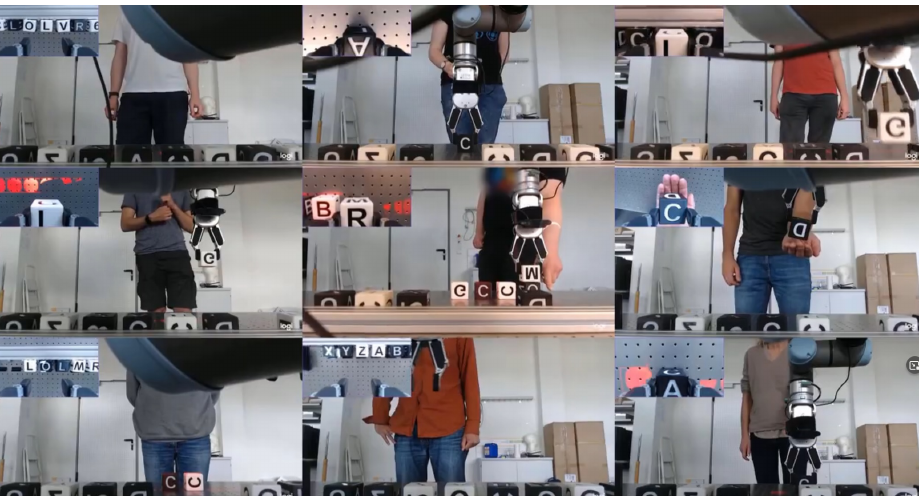
Figure 1. Previous field study for natural human-robot interaction using the Wizard of Oz method. A video summary can be found here: https://youtu.be/JL409R7YQa0 (accessed on 18 January